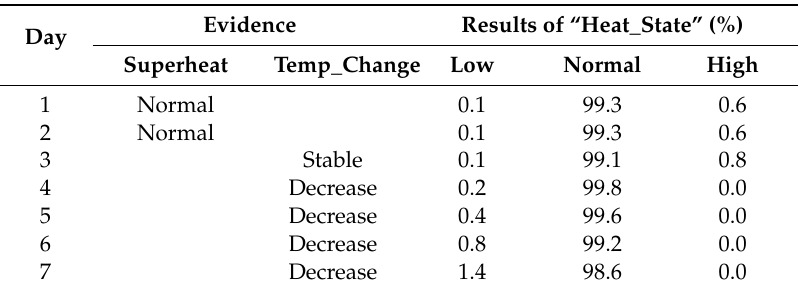
Table 5. Evidence and results of continuous calculation for Case B.